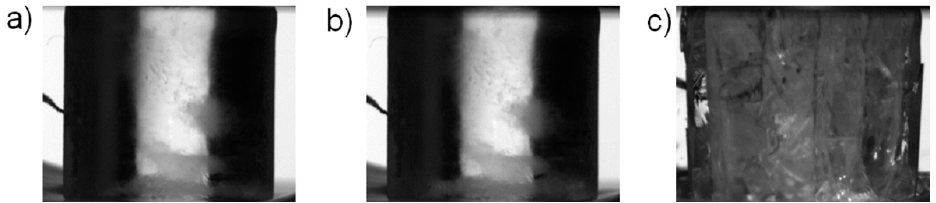
Figure 8. Examples of video frames recorded in the quasi-static test QS_m20_01: ( a ) prior to loading, ( b ) at maximum load, and ( c ) 0.1 s after the previous frame (zero load). The full video is provided as supplementary material